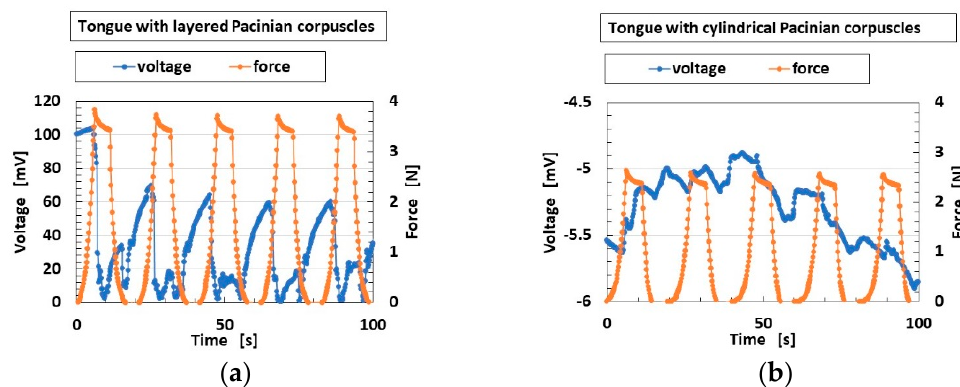
Figure 9. Experimental results of built-in voltage by normal force: ( a ) for layered Pacinian corpuscles; and ( b ) for cylindrical Pacinian corpuscles.